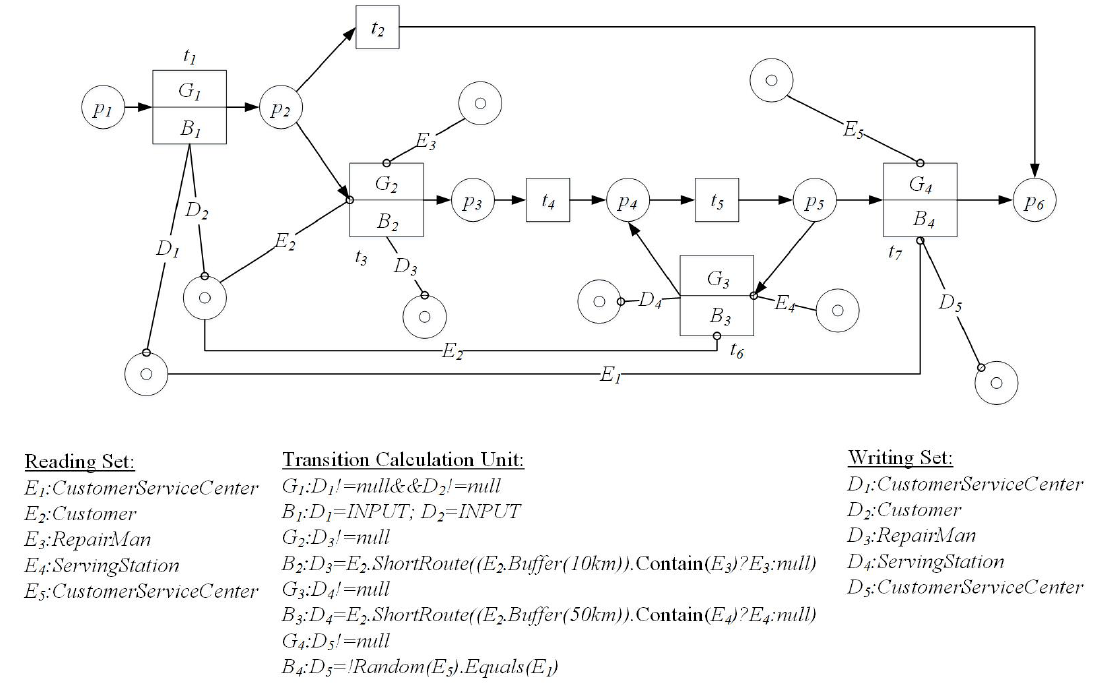
Figure 5. GCWF-net model of repair